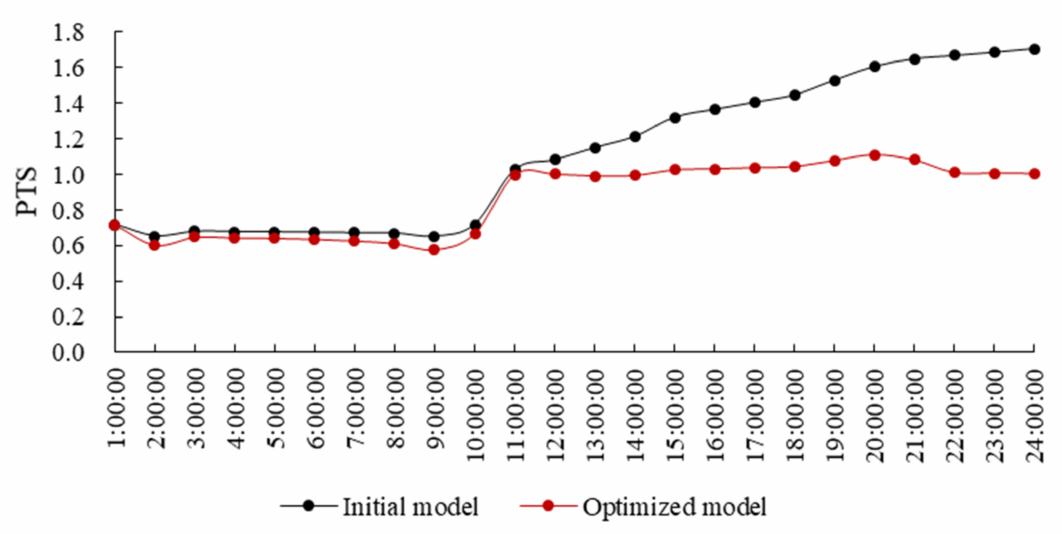
Figure 7. Variation of hourly average PTS between the initial model and the optimized model in